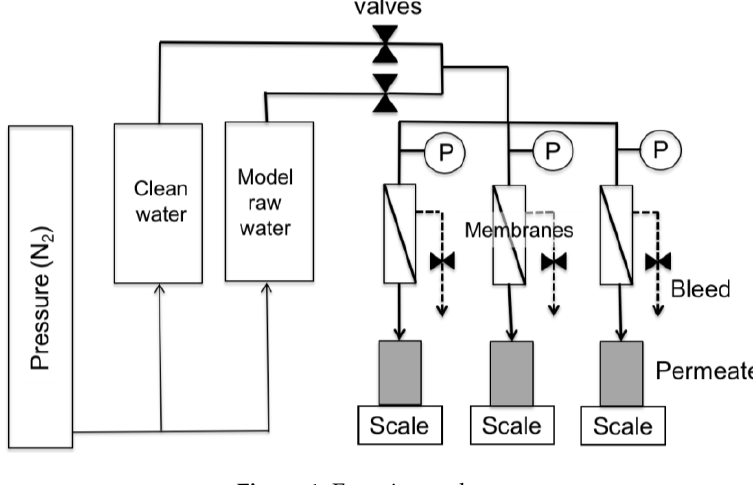
Figure 1. Experimental setup.